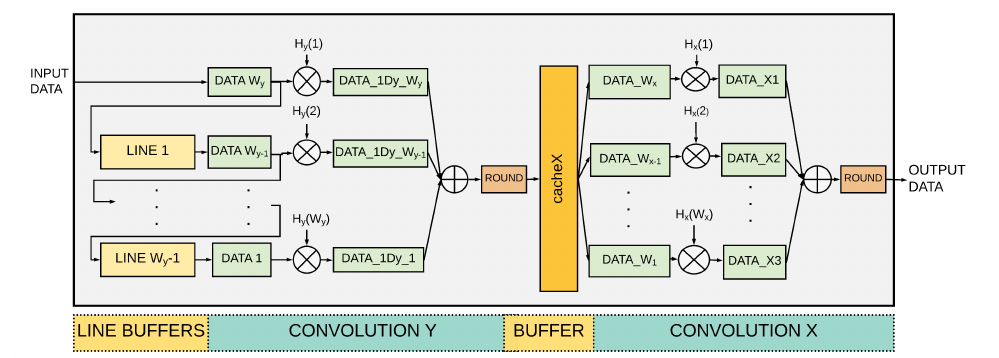
Figure 14. A block diagram for the 2-D convolution with a separable W y × W x kernel. After initialization, an image sample is output from each line buffer into a